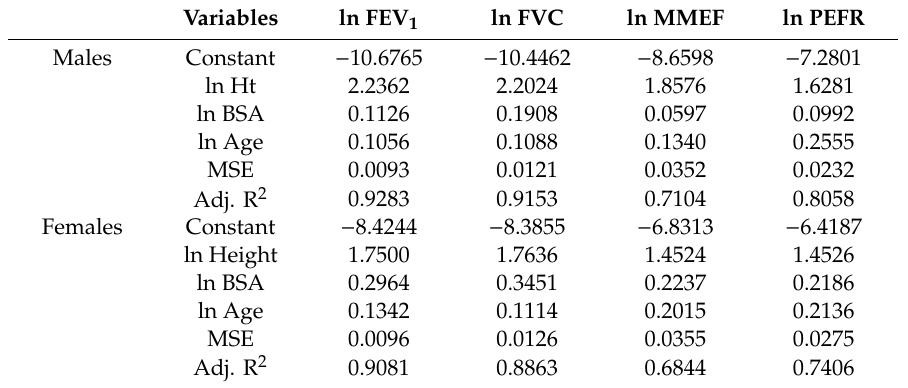
Table 3. Multiple regression coe ffi cients and constants for the predicted spirometric parameters.